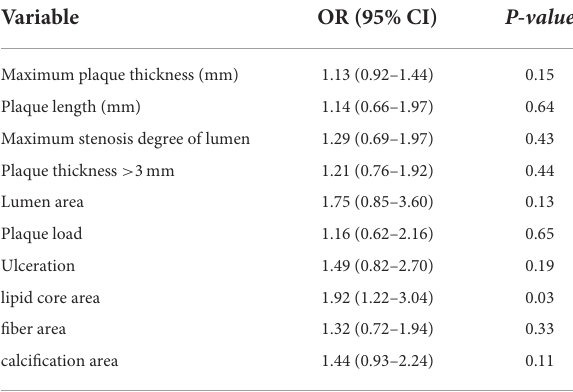
TABLE 3 Associations between plaque high-risk features and ESUS.